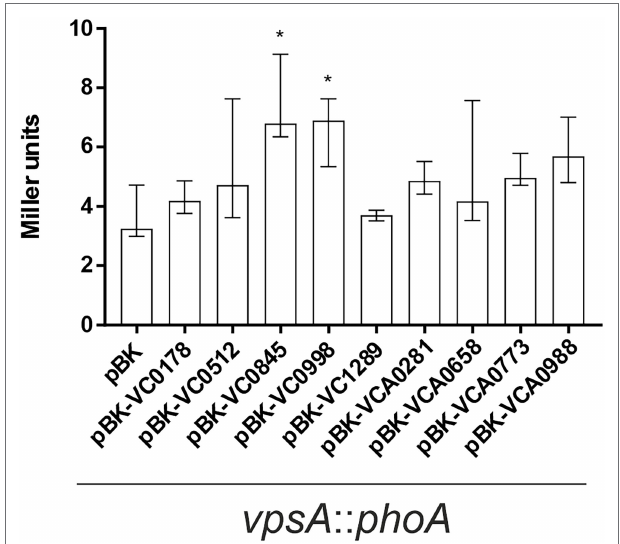
FIGURE 8 | Impact of ibr gene expression on vps gene expression. Alkaline phosphatase activities (in Miller Units) were measured from overnight cultures of vpsA :: phoA with empty vector (pBK) and vpsA :: phoA with expression plasmids of respective ibr genes, at 24 ° C in LB-Km/Ara, as indicated. Shown are the medians ± IQR from at least eight independent measurements. An asterisk indicates a significant difference to WT pBK (* p < 0.001 Kruskal–Wallis test followed by post hoc Dunn’s multiple comparisons).